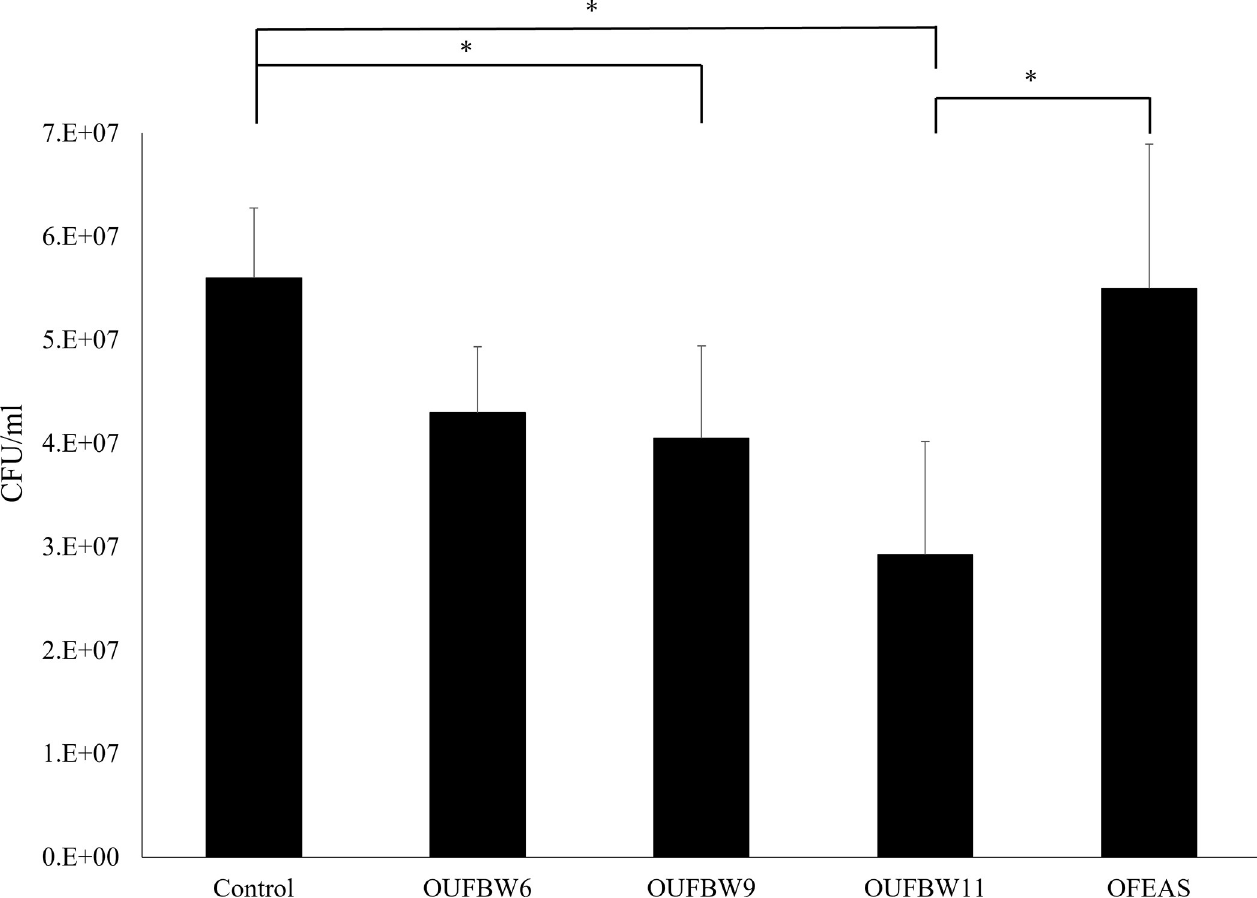
Fig 1. 24-h Biofilm quantification of C . albicans using the CFU assay. Black bars represent the mean colony count detected from specimens with C . albicans (n = 10 in each group), and the asterisk ( � ) indicates significant between-group differences ( p < 0.05).